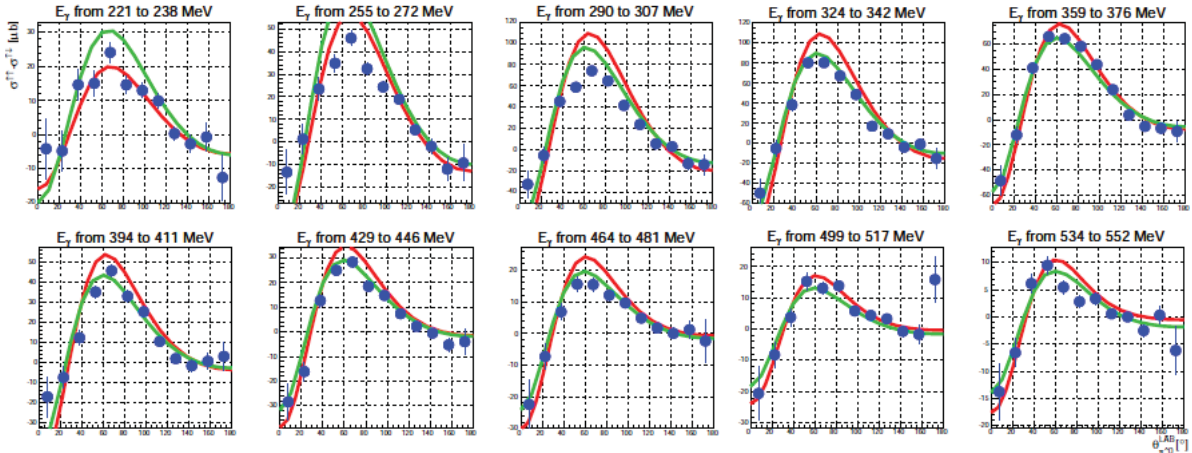
Figure 5. Helicity dependent di ff erential cross section for the semi-exclusive channel γ d → π 0 X . The A2 results (blue circles) are compared to the MAID model without (red line) [14] and with (green line) the Impulse Approximation correction by A. Fix based on